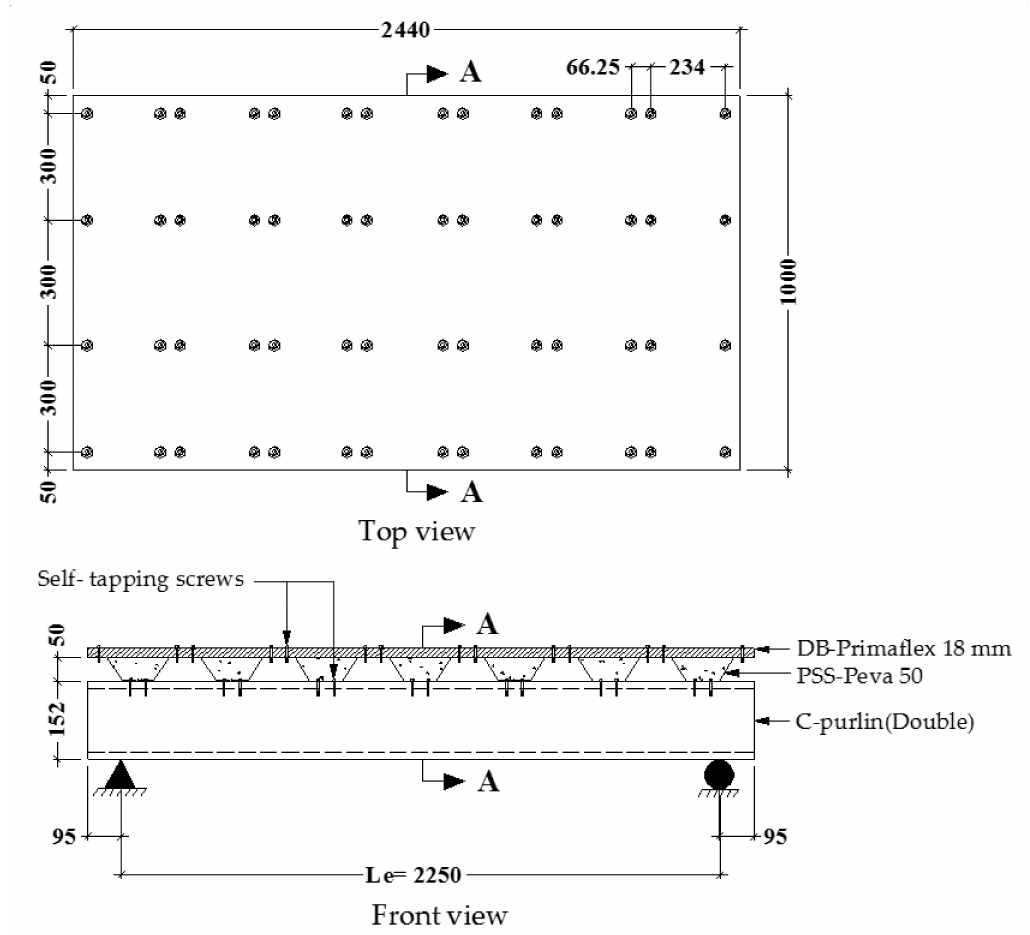
Figure 5. CBPDS specimen with perpendicular PSS direction (all dimensions in mm).